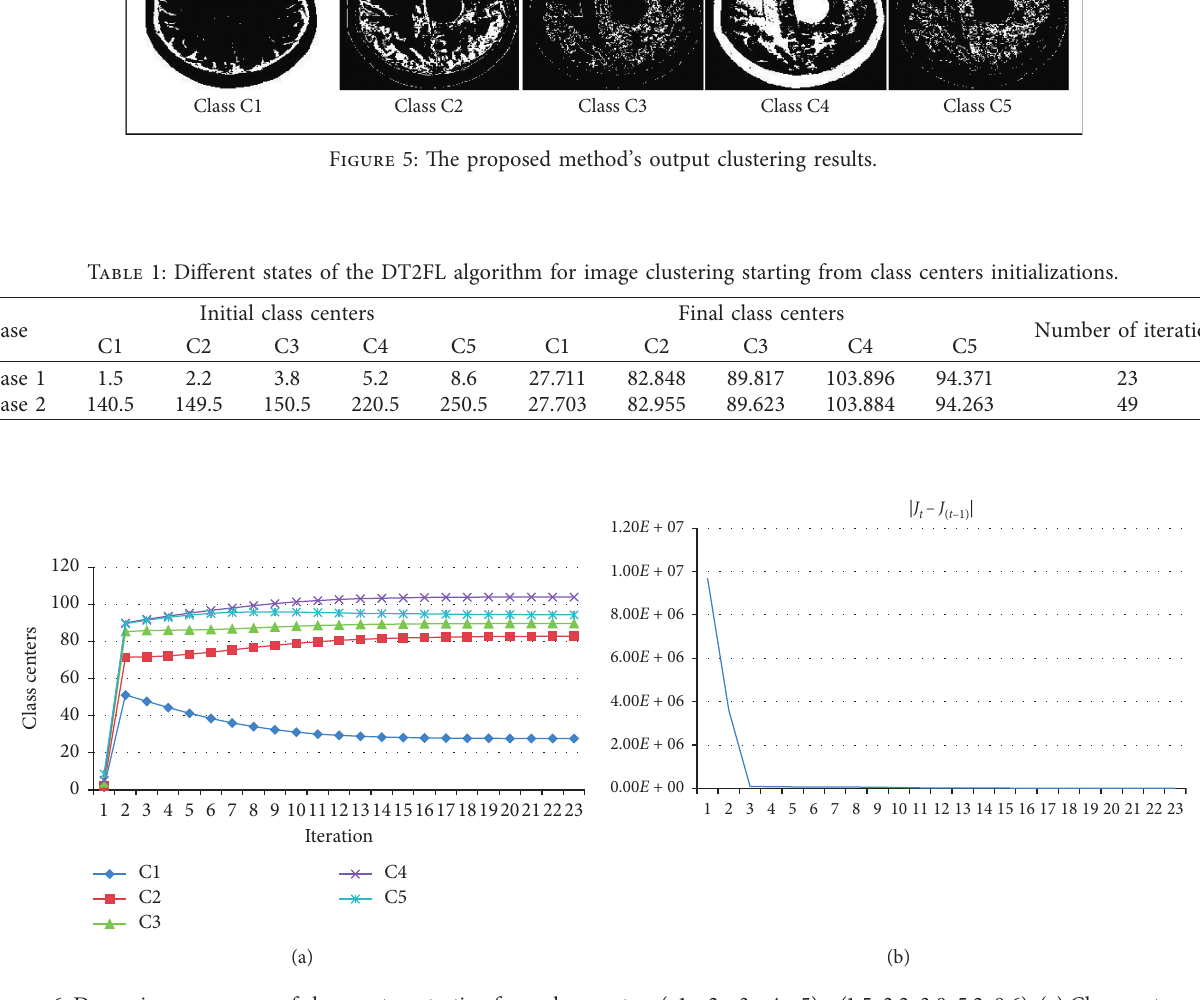
Figure 6: Dynamic convergence of class centers starting from class centers (c1, c2, c3, c4, c5) � (1.5, 2.2, 3.8, 5.2, 8.6). (a) Class centers and (b) error.